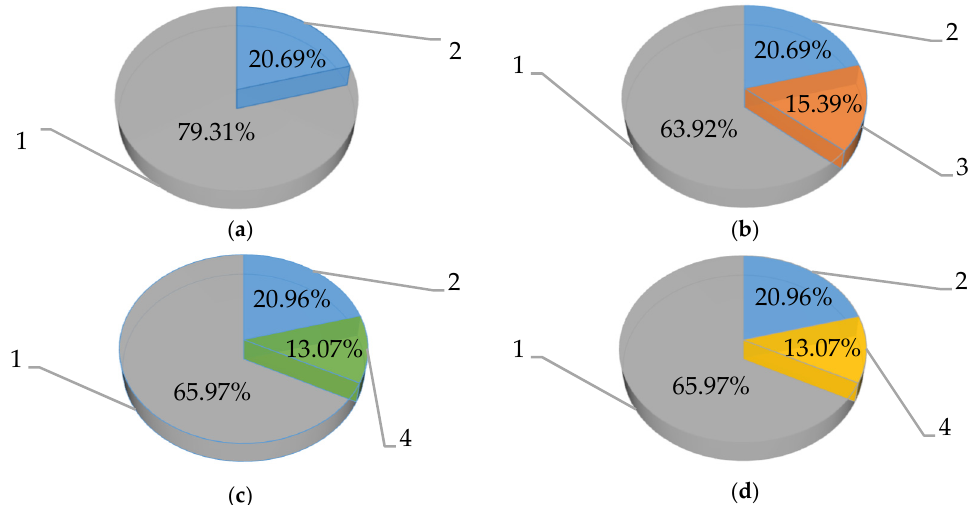
Figure 5. The heat of fuel combustion structure for the different TPPs with BPSTs producing electricity (without heat load) at the ambient temperature of 20 °C. 1—the net power of BPST power unit; 2—the heat losses in the cold source; 3—the net power of LPT power unit; 4—the net power of CO2 power unit. ( a ) Case 1, ( b ) Case 2a, ( c ) Case 2b (with CO 2 condensation), and ( d ) Case 2b (without CO 2 condensation).